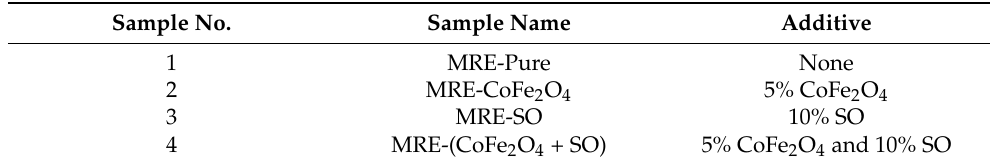
Table 1. MRE samples with additive contents. Sample